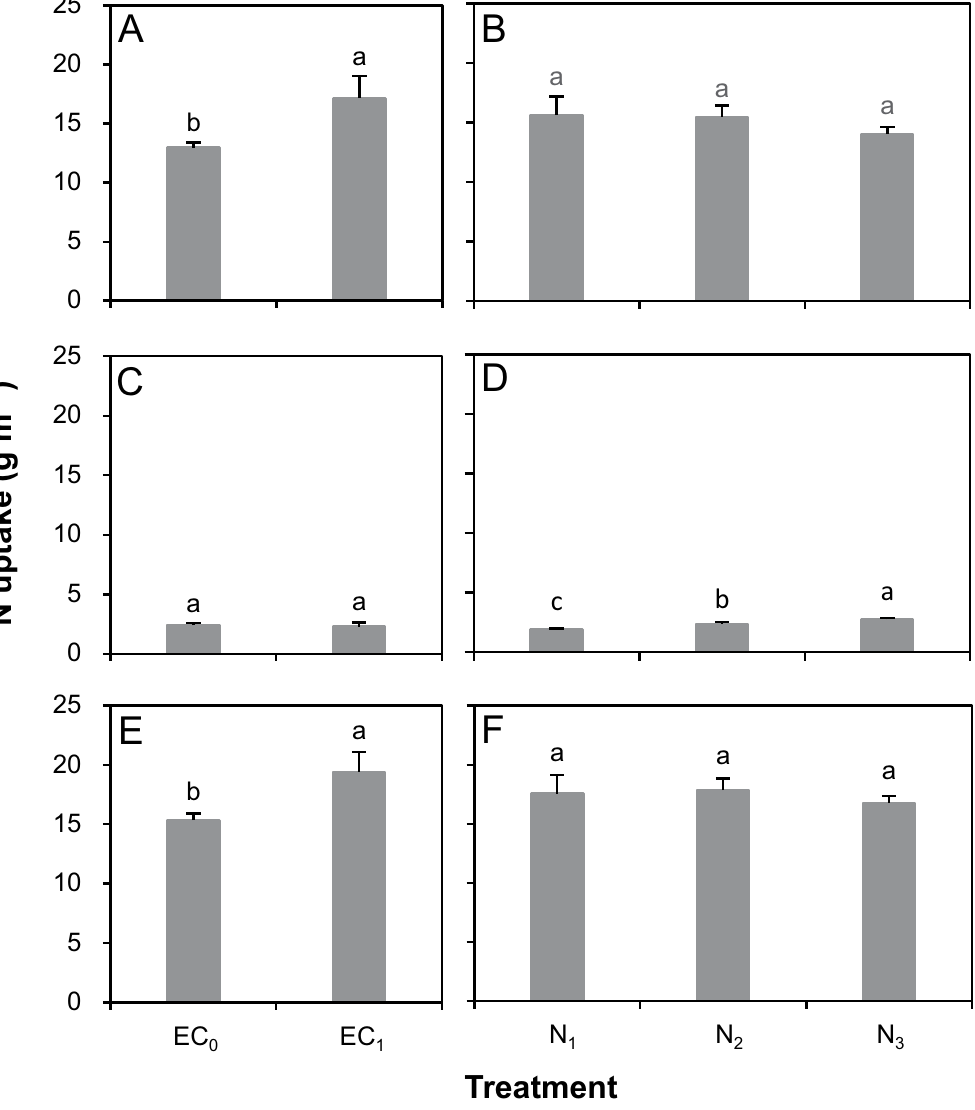
Figure 2. Uptake of non-fertilizer N ( A , B ), fertilizer N ( C , D ), and total N ( E , F ) in aboveground biomass in a rice cultivar Liangyoupeijiu as affected by earthworm castings (EC 0 : 0 g m − 2 ; EC 1 : 17 g m − 2 ) and N rates (N 1 : 9 g m − 2 ; N 2 : 12 g m − 2 ; N 3 : 15 g m − 2 ) in 2016. The interactive effect between earthworm casting treatment and N rate on these parameters were not significant. Error bars represent SE ( n = 9 for each earthworm casting treatment, and 6 for each N rate). Within each graph, columns with the same letters are not significantly different at the 0.05 probability level (LSD